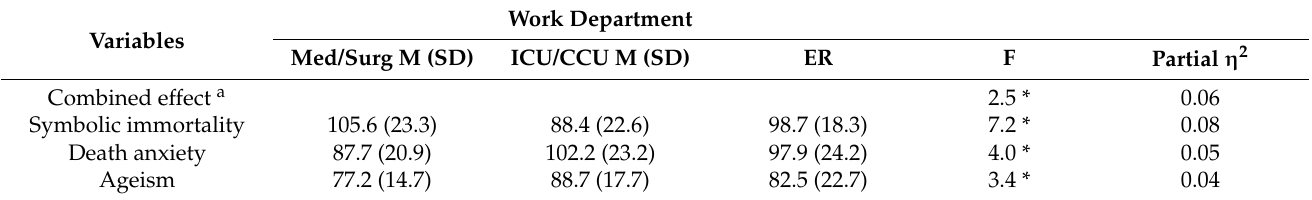
Table 2. One-way univariate and multivariate ANOVA of the study variables of the nurse groups ( n = 163).